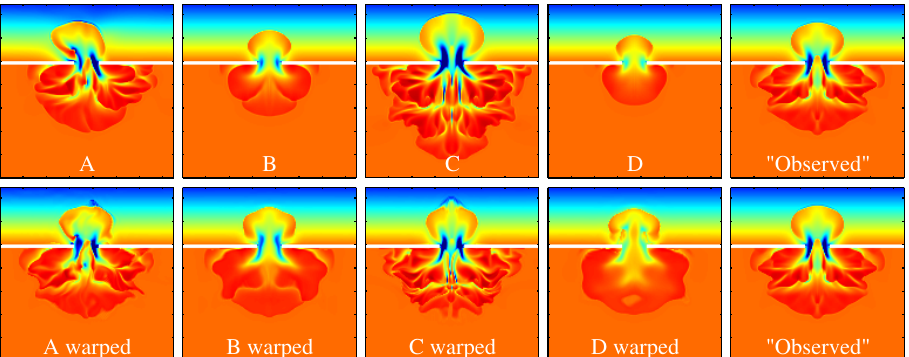
Fig. 6. Predictions A, B, C and D, the “observations” (taken as the model results for 0 ◦ ) and the corresponding deformed predictions that minimize the point-wise mismatch between predictions and observations. The labels are chosen such that the lower the label in the alphabet, the higher the quality that the prediction is probably diagnosed with upon visual inspection. The axes are as in Fig. 3.